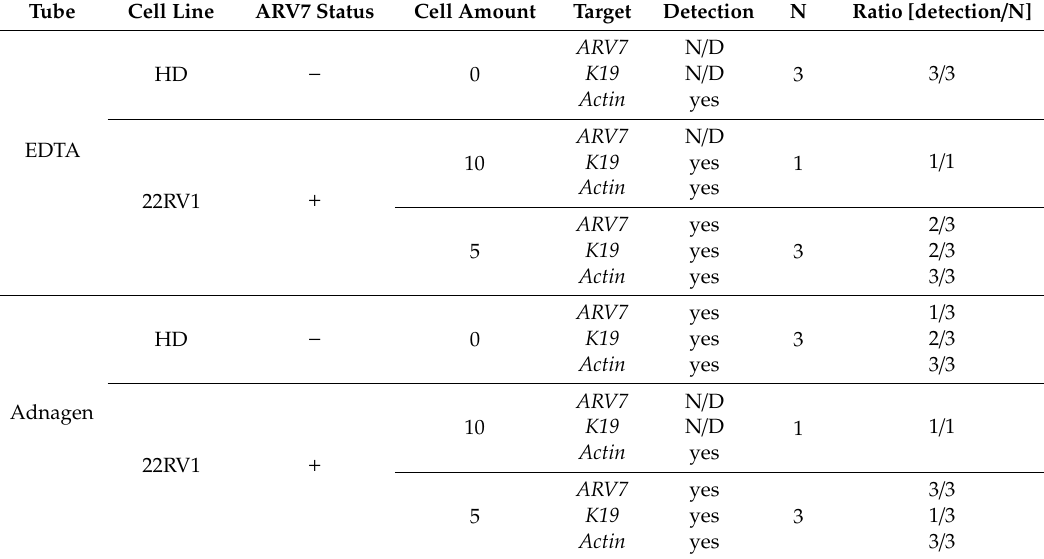
Table 3. Influence of sample tubes and sample storage times on ARV7 detection limits and assay specificity. ARV7 status is highlighted as “ + ” for positive and “ − “ for negative samples. Detection of gene expression was confirmed when at least 2 / 3 triplicates were positive in qPCR analysis. N represents the number of repetitions performed per experimental setting. The ratio is defined as the frequency at which any specific gene was detected out of the N repetitions. N / D signifies no gene expression or gene expression above the set threshold of 35